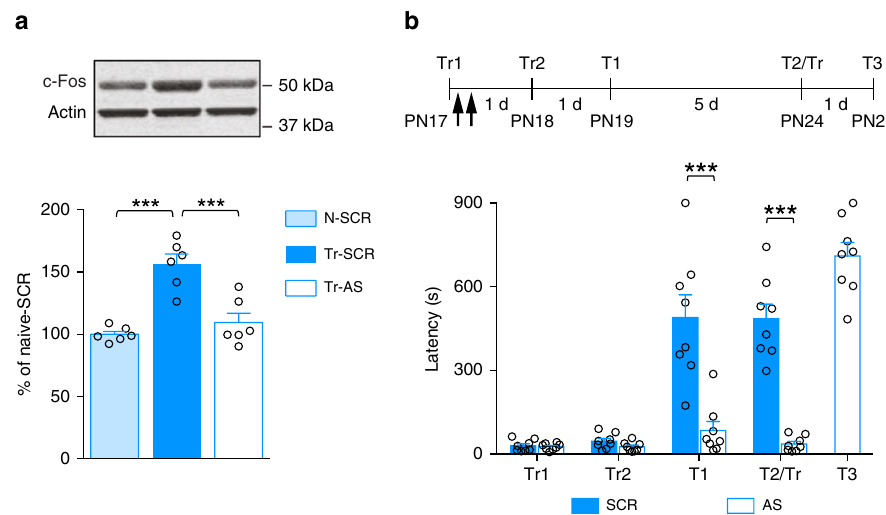
Fig. 6 Blocking c-Fos induction after the fi rst learning experience precludes the second learning from promoting functional competence. a Representative examples and bar graphs showing c-Fos densitometric western blot analyses of dHC extracts obtained from naive (N) and trained (Tr) rats, which received two hippocampal injections of scrambled (SCR) ( n = 6 rats per group) or c-Fos-antisense ODN (AS) ( n = 6 rats), the fi rst immediately after training at PN17 and the second 6 h later. Protein extracts were obtained 24 h after training. Data are expressed as mean percentage ± s.e.m. of the naive group injected with SCR-ODN. *** P < 0.001 (one-way ANOVA followed by Tukey ’ s multiple comparisons test). b Rats received two training trials, one at PN17 (Tr1) and the second at PN18 (Tr2). Rats were injected twice (black arrows) in the dHC with either SCR-ODN ( n = 8 rats) or AS-ODN ( n = 8 rats) against c-Fos immediately after training at PN17 and 6 h later. Rats were tested at PN19 (T1), and at PN24 (T2). At T2, upon entering the